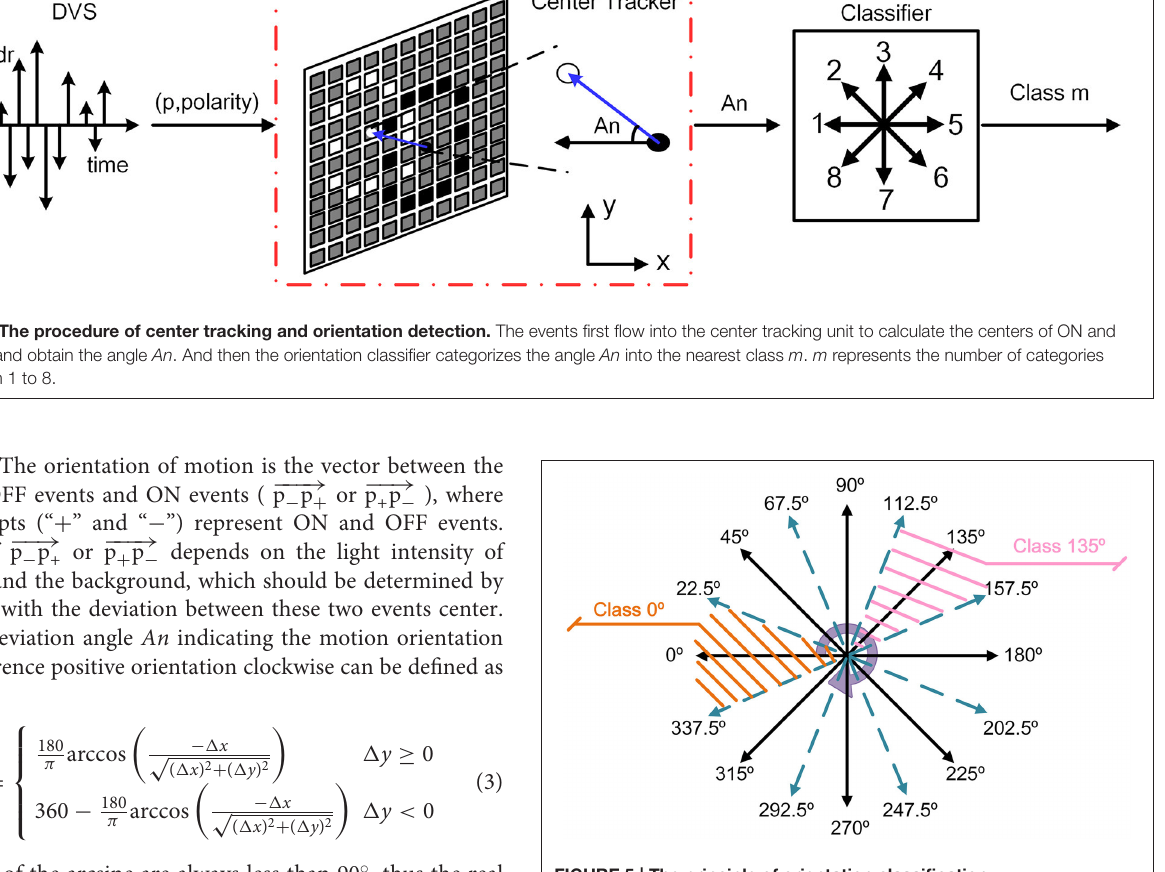
FIGURE 5 | The principle of orientation classification.